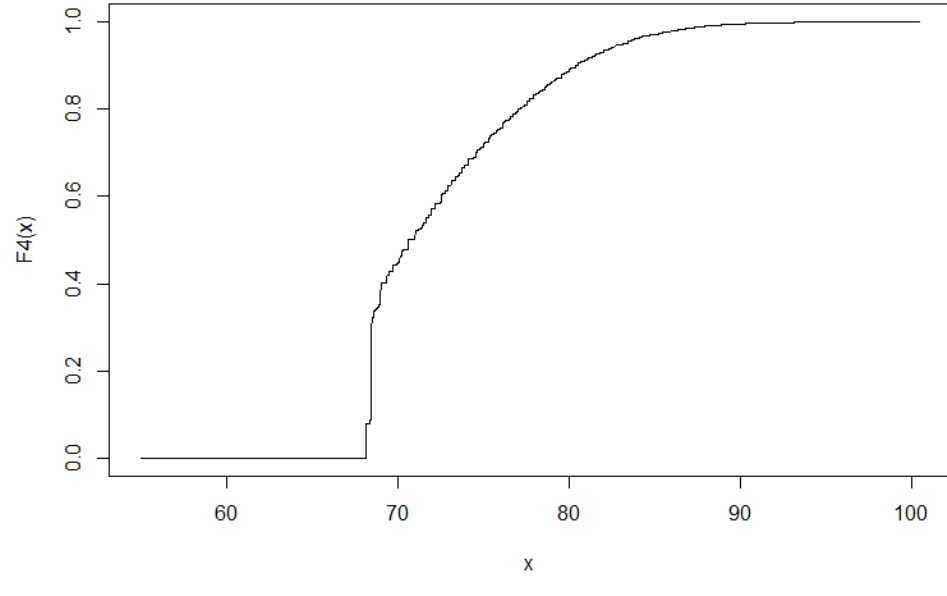
Figure A9. The F 4 bid distribution, source: own figure.